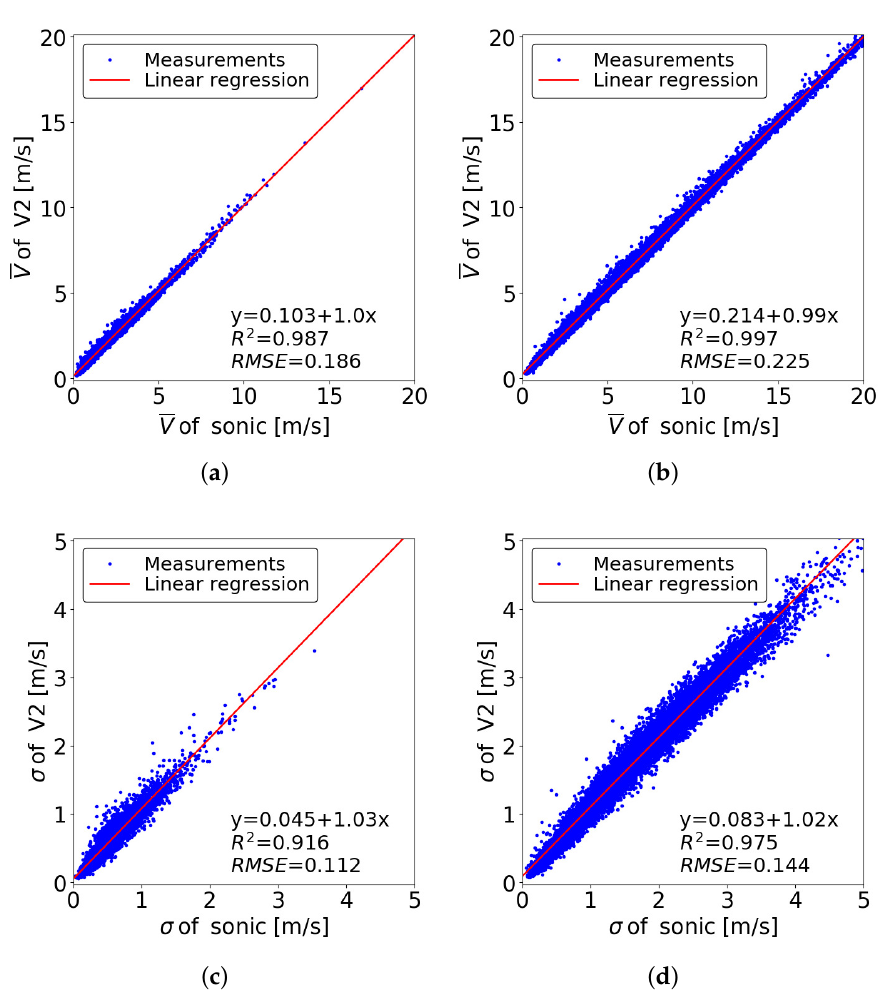
Figure 15. Comparison of measurements at 57 m height. ( a ) 10-min average horizontal wind speed for wind direction between 60 ◦ and 180 ◦ (non-complex terrain); ( b ) 10-min average horizontal wind speed for wind direction between 270 ◦ and 330 ◦ (moderately complex terrain); ( c ) Standard deviation for wind direction between 60 ◦ and 180 ◦ ; ( d ) Standard deviation for wind direction between 270 ◦ and 330 ◦